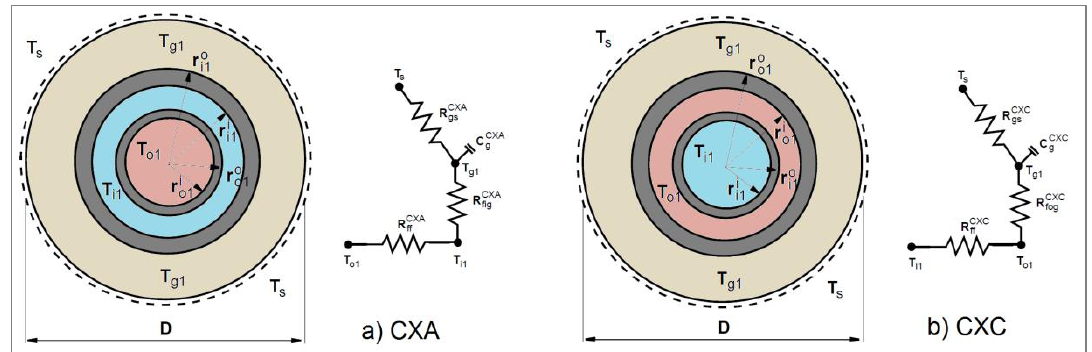
Figure 4. Components of borehole thermal resistance for ( a ) the CXA arrangement; and ( b ) the CXC arrangement.